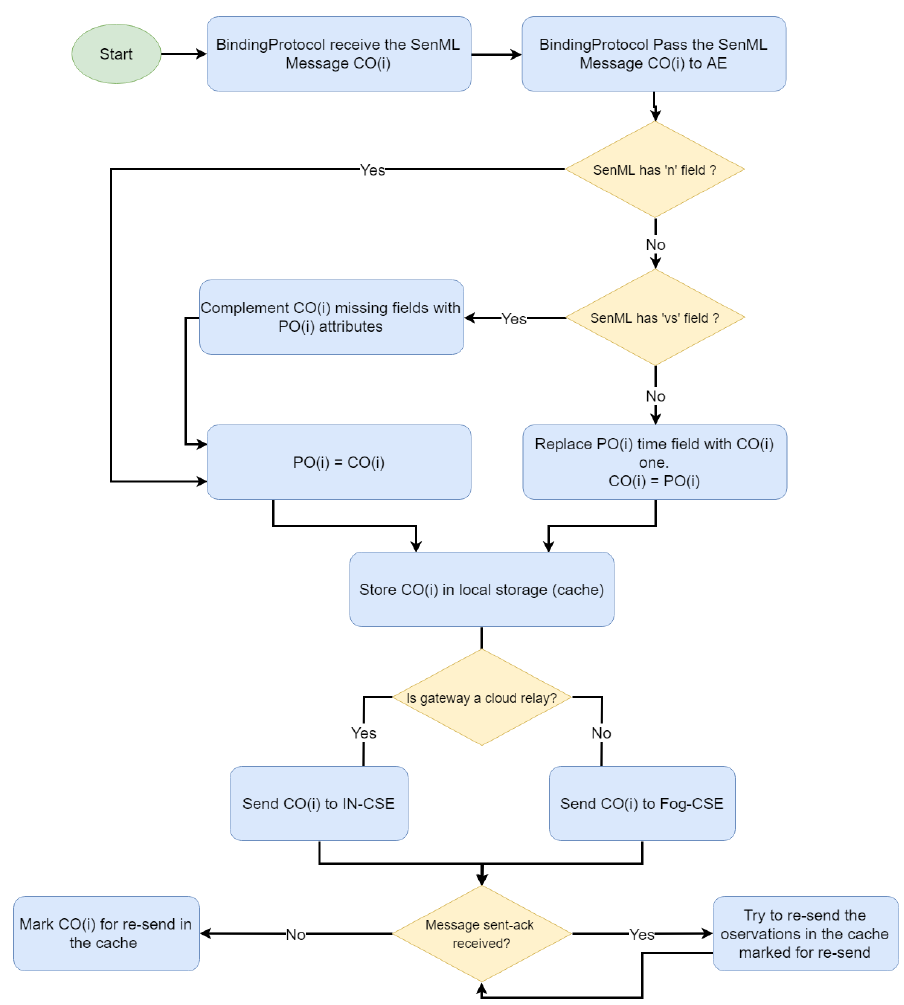
Figure 10. Message handling